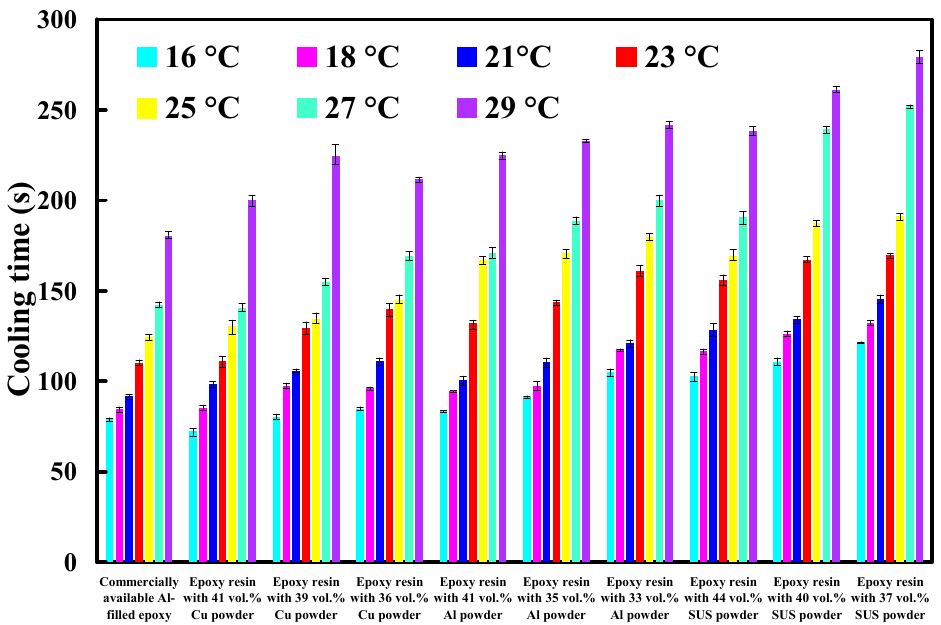
Figure 14. Cooling time of injection molded parts fabricated by ten sets of injection molds cooled with different cooling water temperatures.